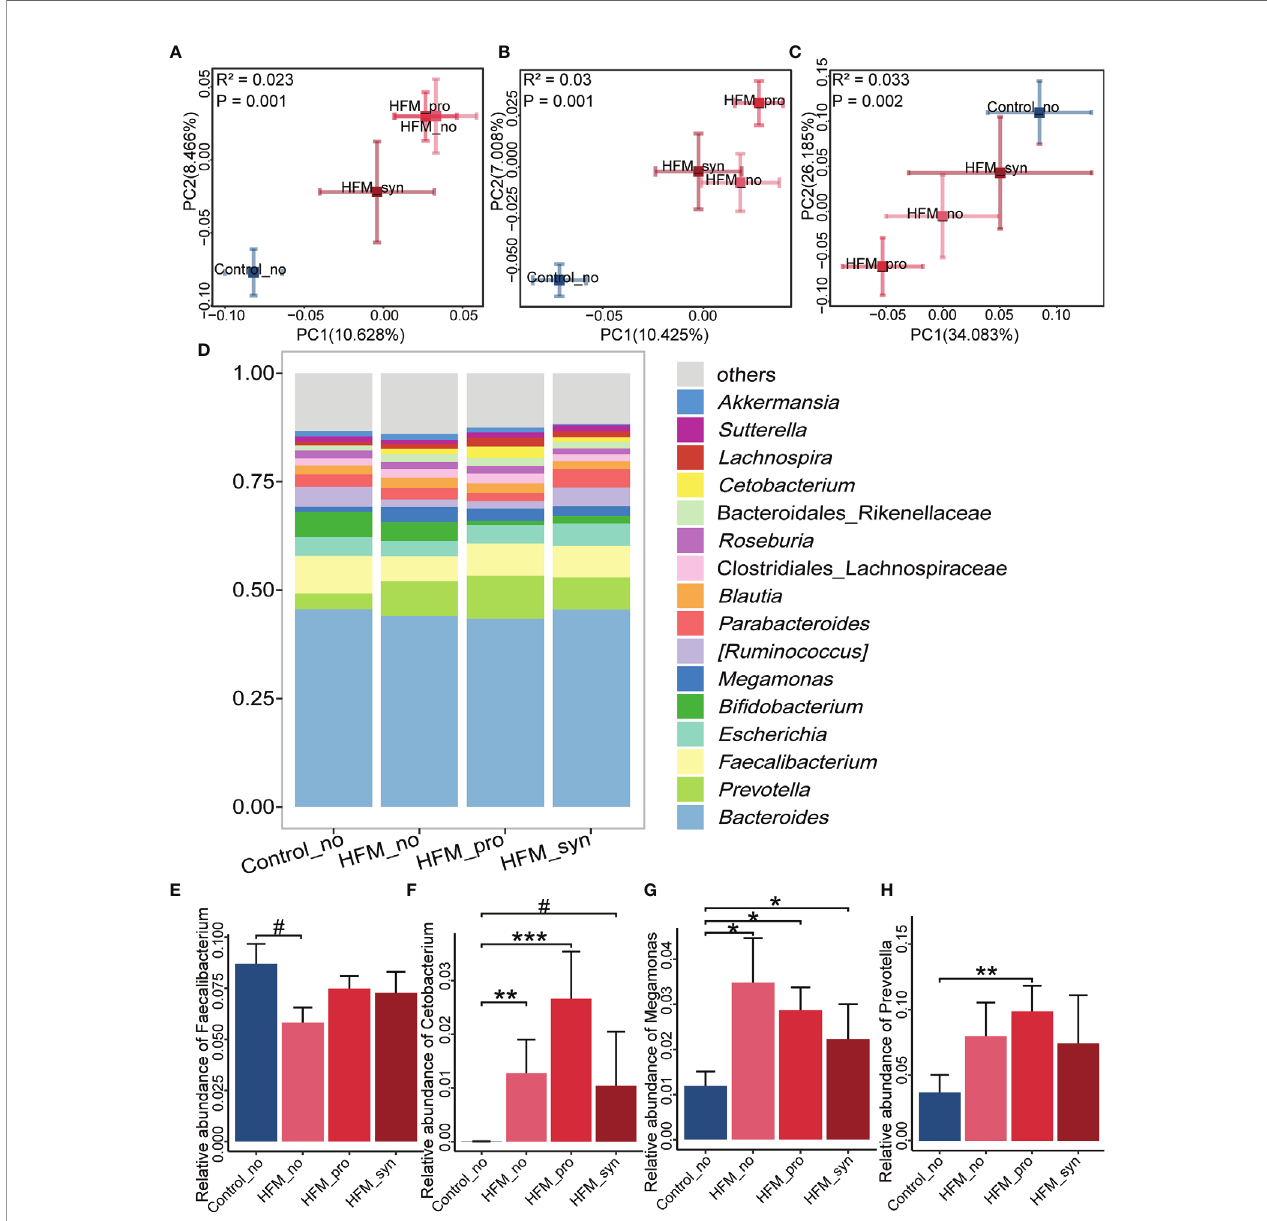
FIGURE 4 | Comparison of the gut microbiota among the probiotics (Pro), prebiotics (Pre) and Synbiotics (Syn) supplements. (A – C) Beta diversity. Principal coordinate analysis (PCoA) based on the Bray-Curtis distance (A) , unweighted UniFrac distances (B) and weighted UniFrac distances (C) revealed the relationship of bacterial communities among the Pro, Pre and Syn groups. The explanation of diversity captured by the coordinate is given as a percentage. (D) Relative abundance at the genus level of the different groups. (E – H) Relative abundances of Faecalibacterium , Cetobacterium , Megamonas and Prevotella between various groups (Kruskal-Wallis rank sum test and multiple comparison between groups adjusted by Benjamini-Hochberg method). * indicates P < 0.05, ** indicates P < 0.01, *** indicates P < 0.001, # indicates P <